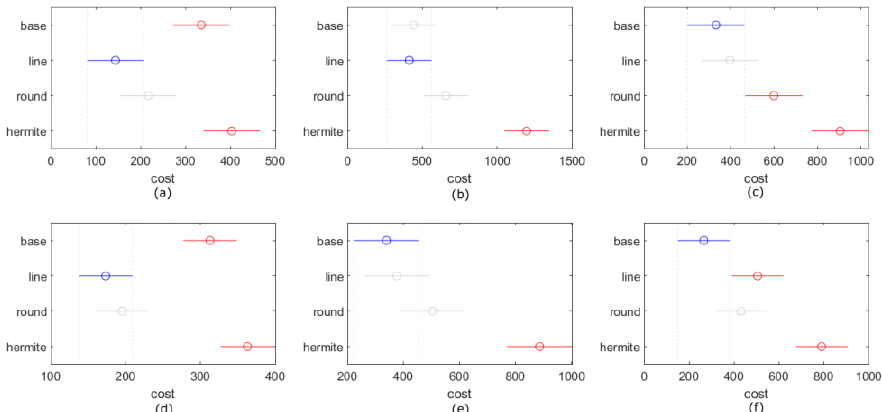
Figure 16. ANOVA results. The links with lowest cost value are shown in blue, links that are not significantly different from the best one are shown in gray, and links that are significantly different are shown in red: ( a ) task 1, cost 1 ; ( b ) task 2, cost 1 ; ( c ) task 3, cost 1 ; ( d ) task 1, cost 2 ; ( e ) task 2, cost 2 ; ( f ) task 3, cost 2 .